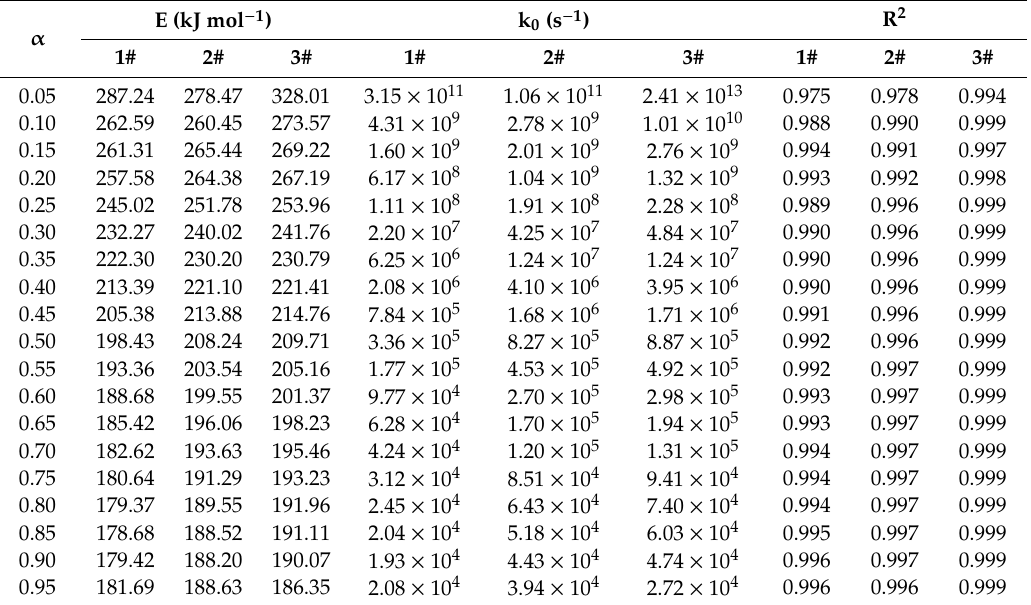
Table 3. Kinetic parameters from the integral isoconversional model of Miura–Maki for coal samples with di ff erent particle sizes.